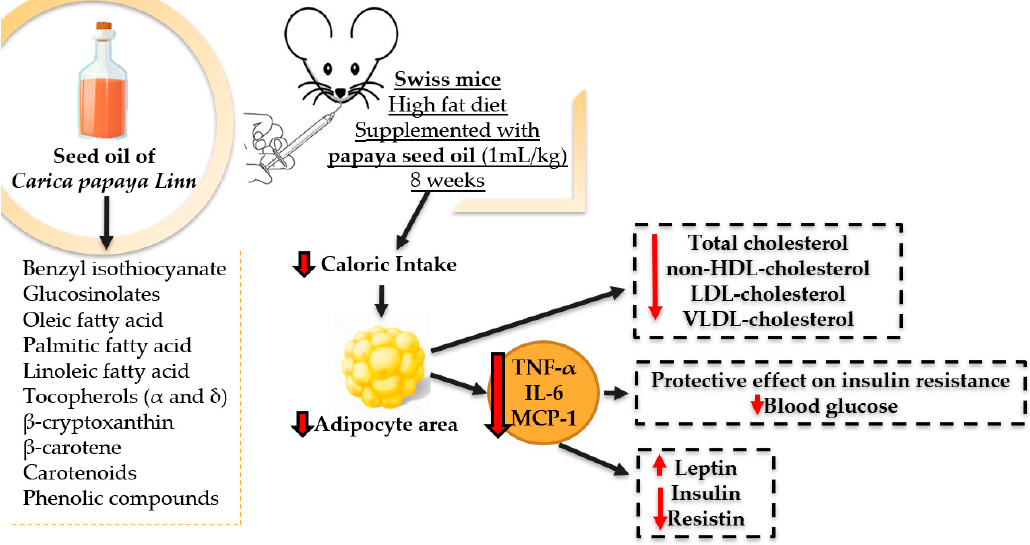
Figure 7. Effects of papaya seed oil supplementation in Swiss mice fed a hyperlipidic diet on food intake, adiposity, metabolic, and inflammatory profile.